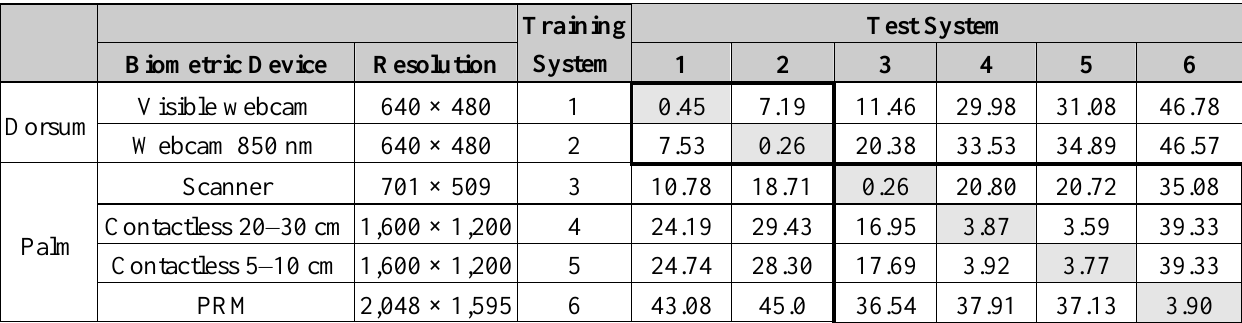
Table 5. Interoperability matrix for Hand-Shape Global Appearance approaches in terms of EER (%).